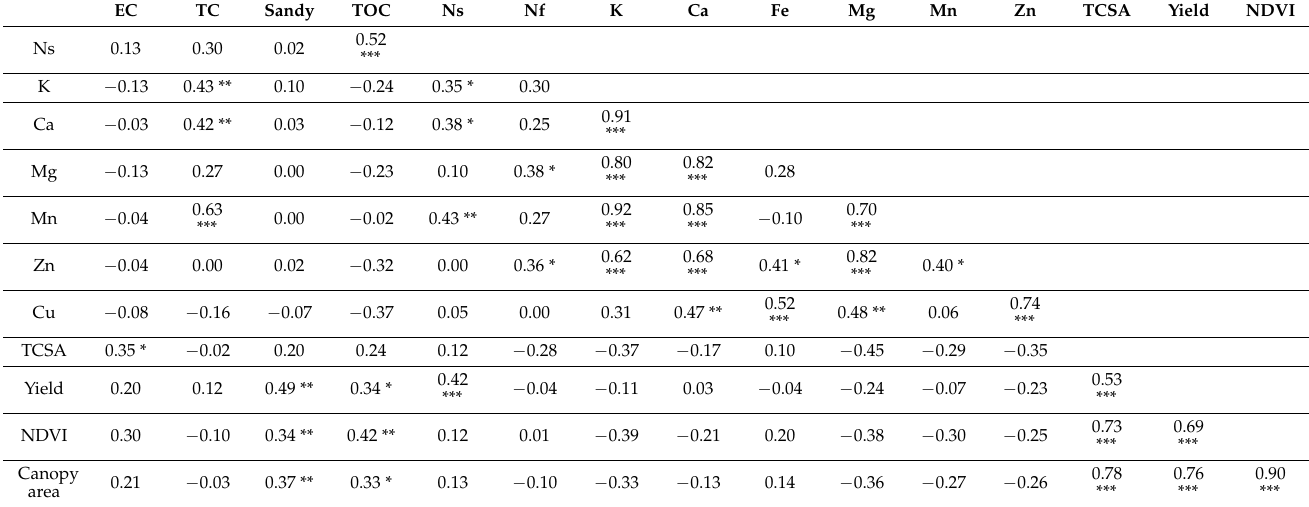
Table 3. Leaf elements concentration and corresponding threshold